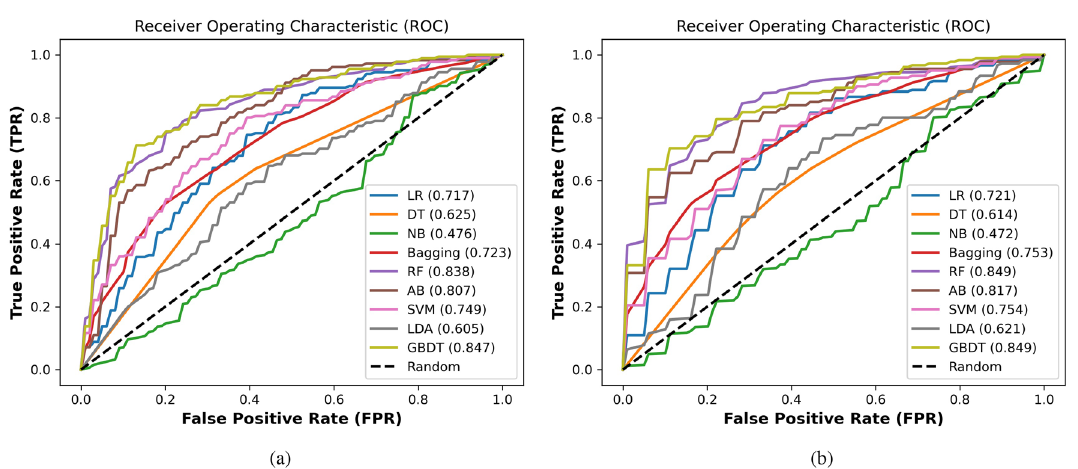
Figure 5. The accuracy box for the proposed system based on the GBDT compared with state-of-the-art classifiers on the protein dataset with ( a ) 4-fold and ( b ) 10-fold cross-validation